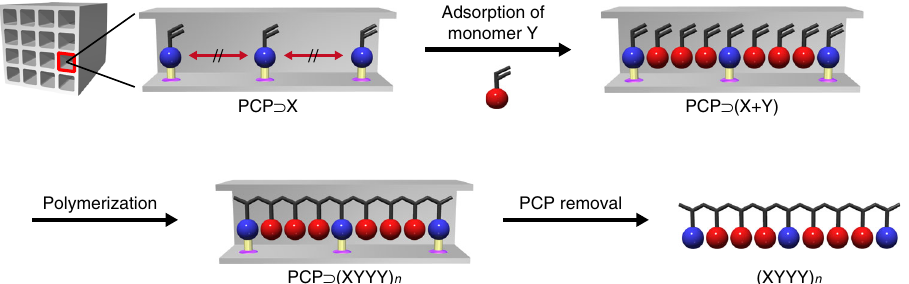
Fig. 1 Schematic illustration of sequence-regulated radical copolymerization using PCPs. A vinyl monomer (X) is pre-immobilized at a regular interval along the nanochannels of a PCP (PCP ⊃ X). Another vinyl monomer (Y) is then incorporated into the PCP, giving a host – guest composite (PCP ⊃ (X + Y)). Polymerization of the monomers in the composite followed by the removal of host structure produces sequence-regulated copolymers re fl ecting on the periodicity of the PCP